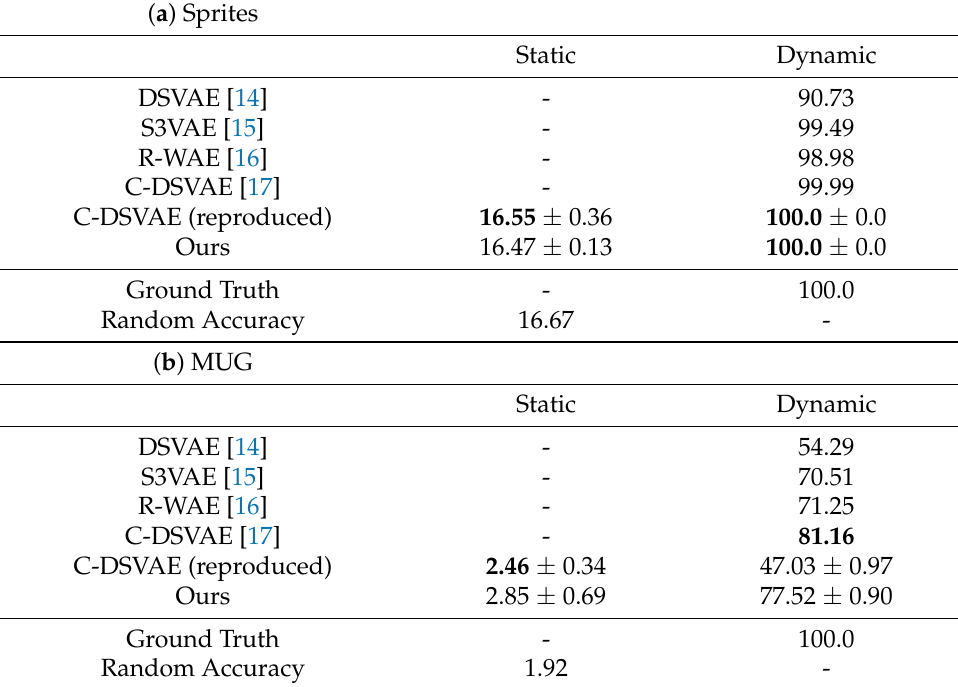
Table 5. Classification accuracy (%) for the fixed dynamic latent variables and randomly sampled static latent variables. For C-DSVAE (reproduced) and ours, the average classification accuracy over ten runs is presented; the others are taken from the literature